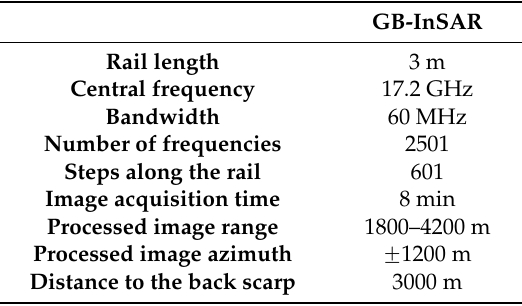
Table 2. Parameters of the employed radar system [49].